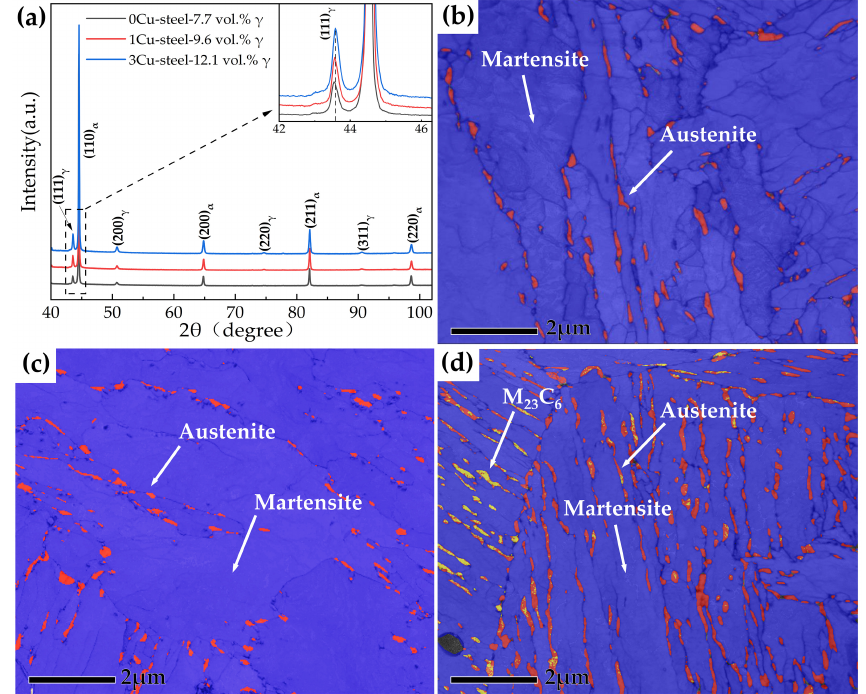
Figure 8. ( a ) XRD patterns of the three steels with different Cu content tempered at 600 °C; ( b – d ) depict the TKD band contrast (BC) and phase maps of 0Cu, 1Cu, and 3Cu steels tempered at 600 °C, respectively. The blue, red, and yellow colors signify the martensite, reversed austenite, and M 23 C 6 phase, respectively.